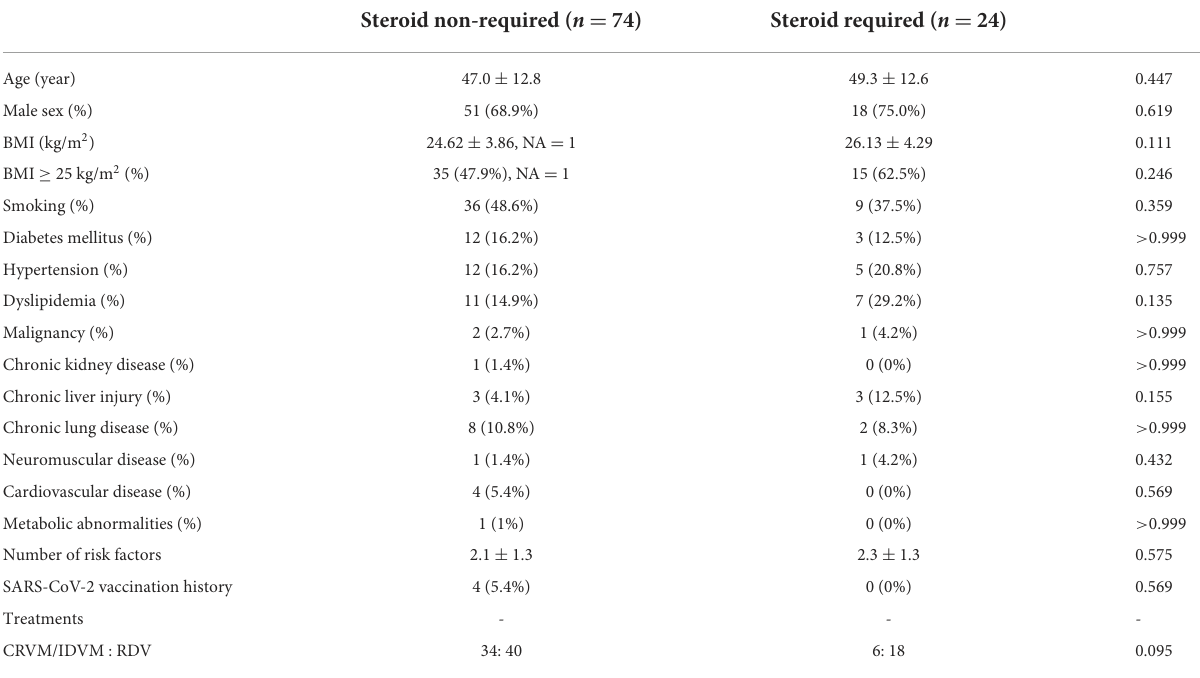
TABLE 1 Patient’s